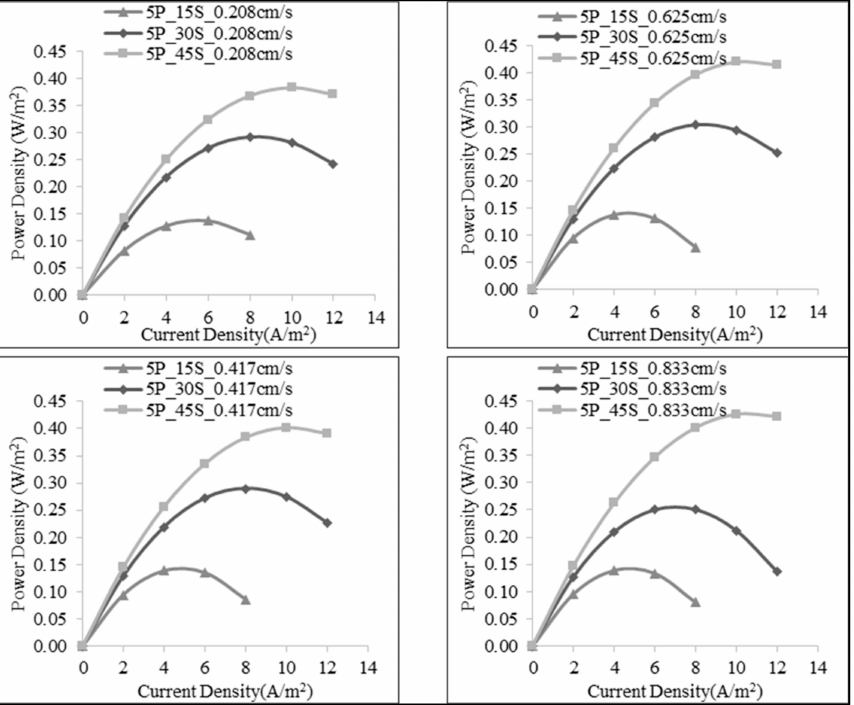
Figure 8. The effect of the salt ratio of feed solutions on power density for 5 membrane pairs. (XP_YS_Zcm/s indicates X membrane pair, Y salt content of HSS and Z feed velocity).